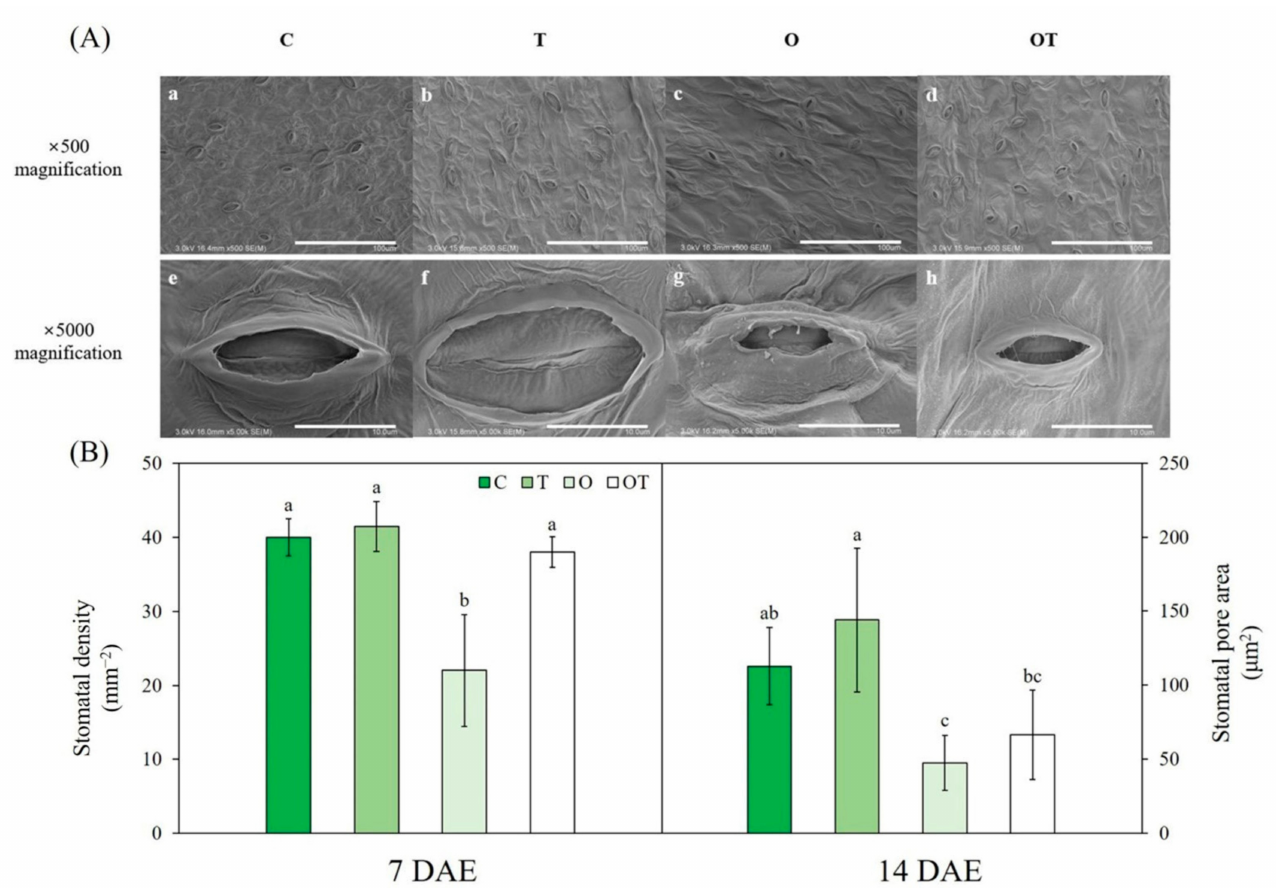
Figure 7. ( A ) Field emission scanning electron micrographs (A–H) and ( B ) stomatal density and stomatal pore area of Brassica juncea L. under different ambient and supraoptimal temperatures and O 3 concentrations at 14 DAE. Micrographs under control conditions (A,E); at supraoptimal temperature and ambient O 3 (B,F); at optimal temperature and elevated O 3 (C,F); and at supraoptimal temperature and elevated O 3 (D,H) at 500 and 5000 × magnification, respectively. (a–d) Scale bar = 100 µ m. (e–h) Scale bar = 10 µ m. Data are plotted as mean ± SD ( n = 5). Different letters indicate significant differences among treatments at p < 0.05 according to Tukey’s honestly significant difference test. C: ambient O 3 + optimal temperature; T: ambient O 3 + supraoptimal temperature; O: elevated O 3 + optimal temperature; OT: elevated O 3 + supraoptimal temperature; DAE: days after the beginning of